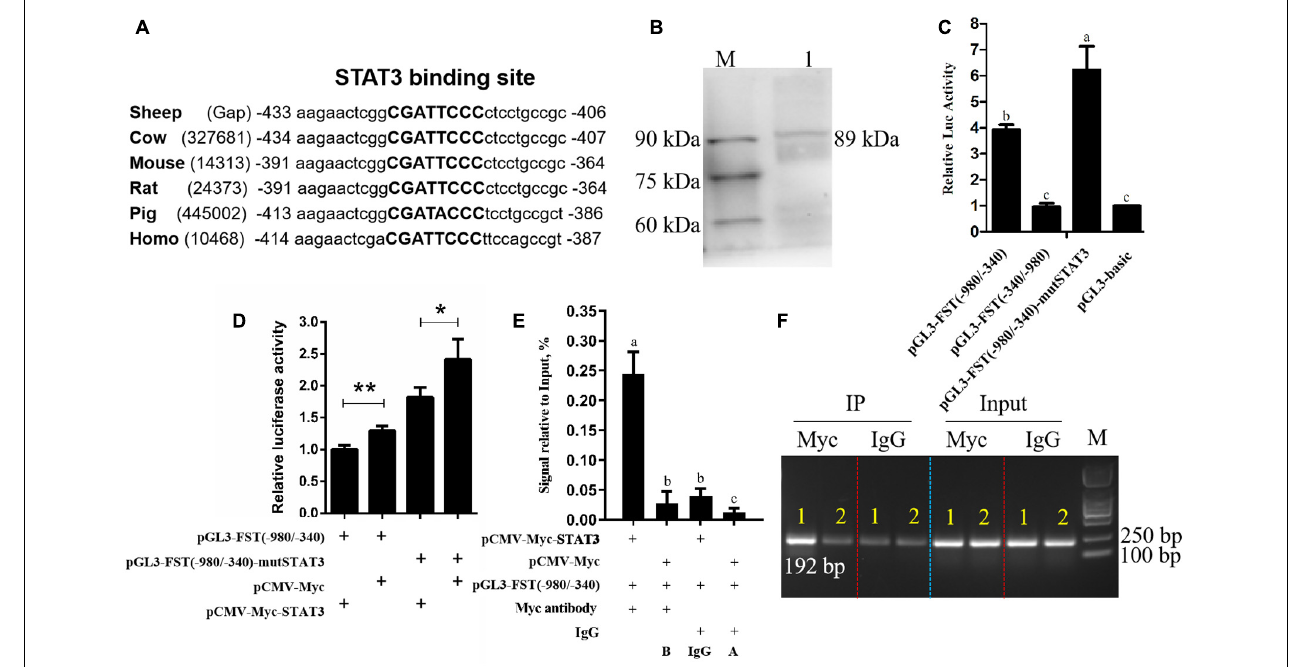
FIGURE 1 | Effects of STAT3 overexpression on FST gene promoter activity. (A) Conservation analysis of STAT3 binding sites in FST promoter among various species, STAT3 binding sites are announced by capital letters and their locations are relative to the first nucleotide (A, + 1) of the initiation codon (ATG) of the FST gene. (B) Western blot recognition of the STAT3 expression vector (pCMV-Myc-STAT3). Lane 1: the lysate of the cells transfected with pCMV-Myc-STAT3 (89 kDa); M: Protein markers (25 kDa-90 kDa). (C) The effect of the mutation of STAT3 binding site on FST promoter activity. (D) Effects of STAT3 on FST gene promoter activity. (E) ChIP-qPCR analysis of the binding of STAT3 to the FST promoter. (F) The agarose gel electrophoresis analysis of ChIP-qPCR products. Lane 1: The qPCR products generated from the immunoprecipitated DNA which was isolated from the cells co-transfected with pCMV-Myc-STAT3 and pGL3-FST(–980/–340); Lane 2: The qPCR products generated from the immunoprecipitated DNA which was isolated from the cells co-transfected with pCMV-Myc and pGL3-FST(–980/–340). All data are representative of three independent experiments and display as the mean ± SEM. For each figure layer, statistical significance was indicated by * P < 0.05, ** P < 0.01, and different letters above error bars indicated a statistical significance ( P <